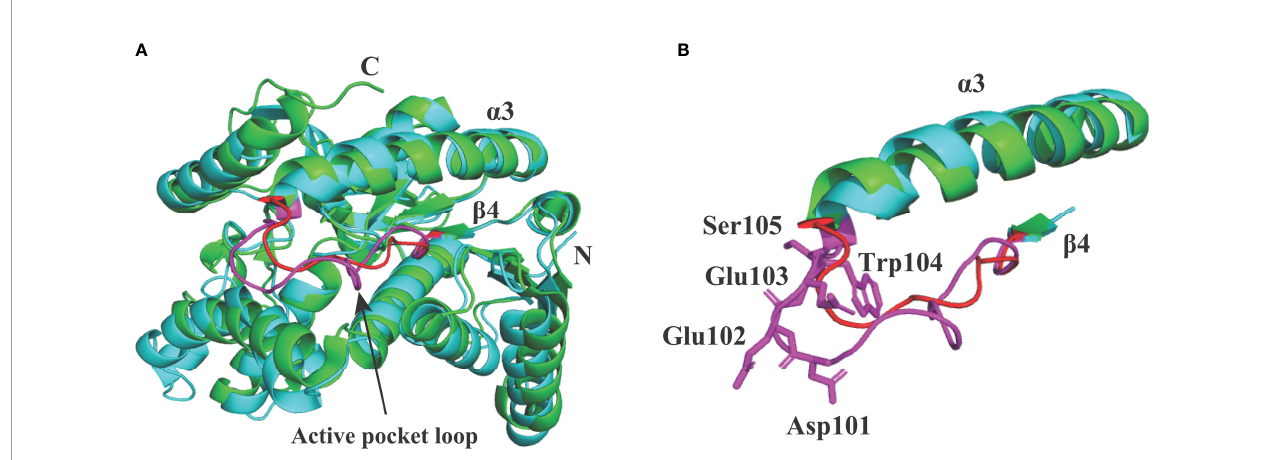
FIGURE 7 | Structural alignment between BoLDH (cyan) and BmLDH (green). (A) The apo structure of BoLDH was superimposed on the apo structure of BmLDH (PDB accession number 6k12). The active pocket loop of BoLDH ( b 4- a 3 loop) was shown in magenta and the corresponding region in BmLDH was shown in red. (B) Differentiation on the b 4- a 3 loops from BoLDH and BmLDH. An extra insertion was observed in the active pocket loop of BoLDH but not present in BmLDH. The two loops were colored in magenta and red, and the fi ve amino acid residues in b 4- a 3 loop of BoLDH were shown in sticks and